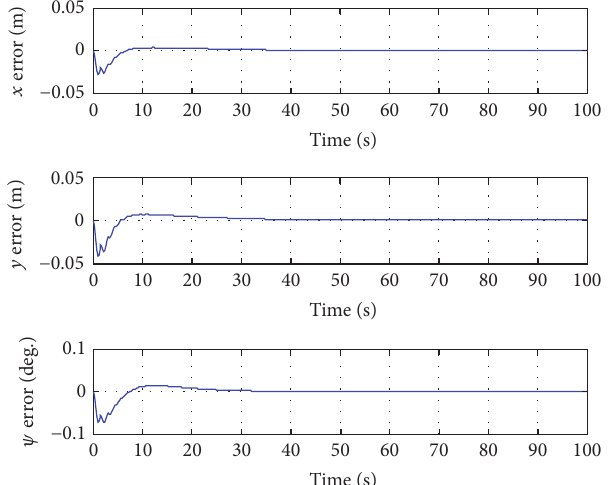
Figure 2: The desired position curves.